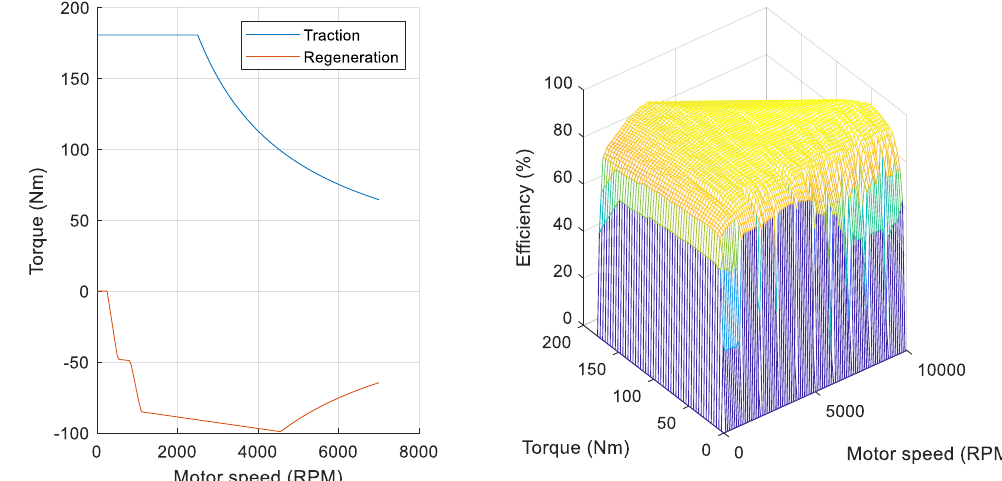
Figure 2. Look-up-tables for basic motor characteristics.